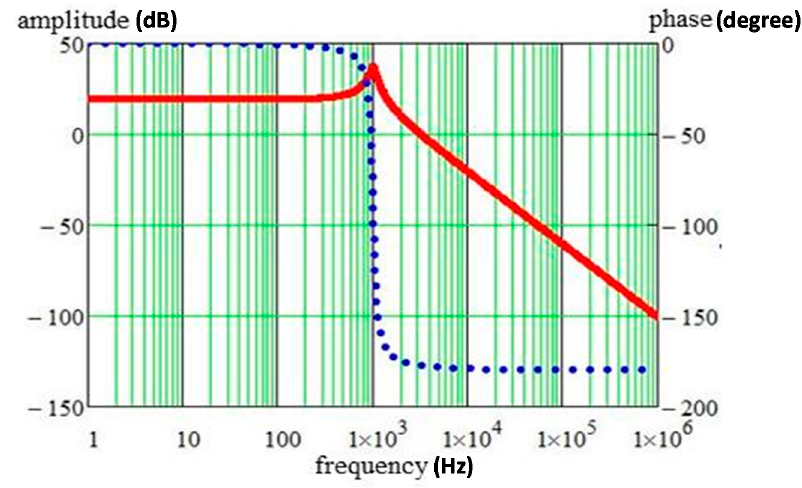
Figure 13. Bode plot of the open loop transfer function of the three-phase inverter.